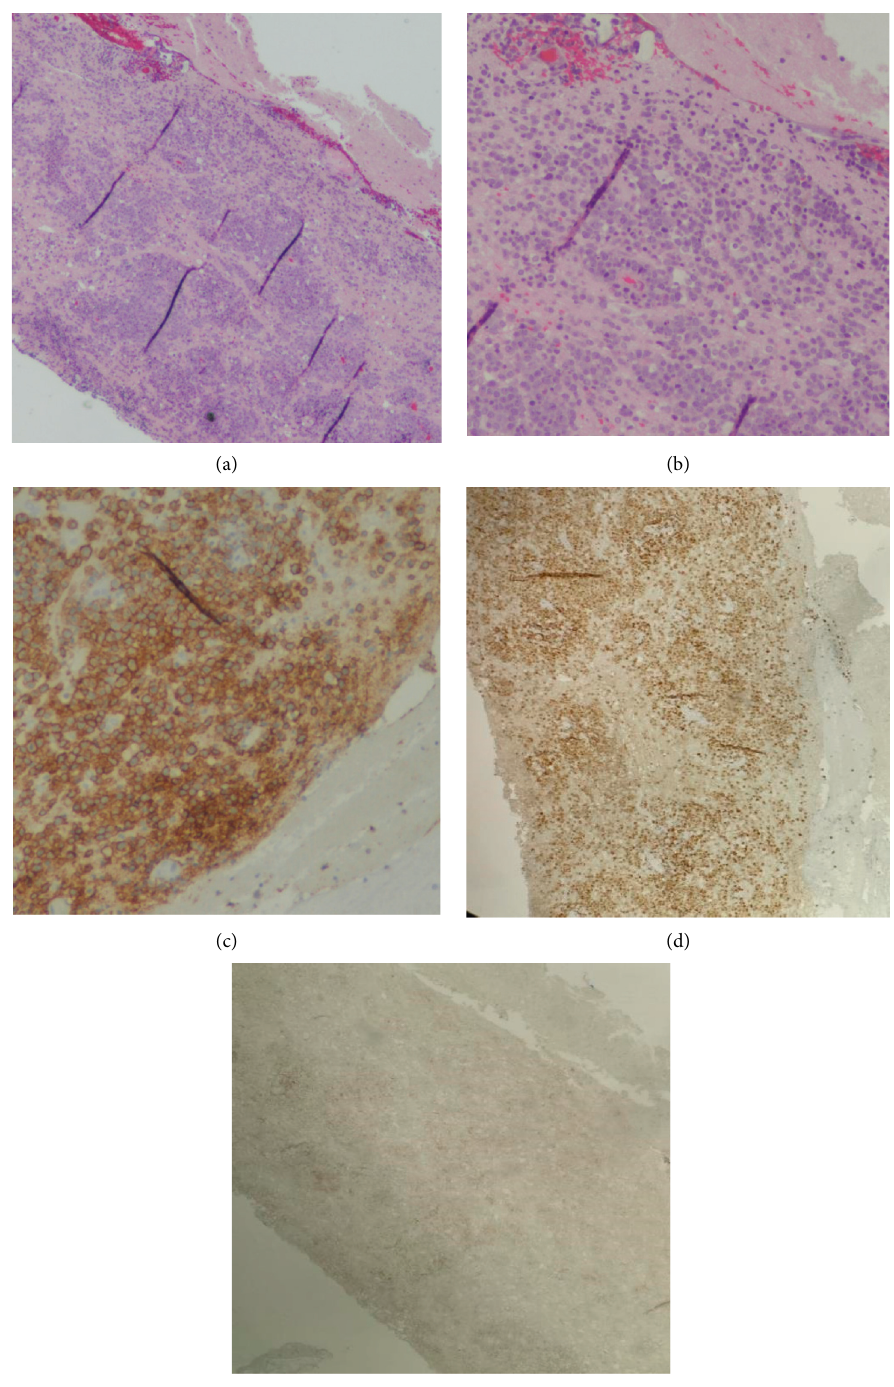
Figure 3: Parietal core brain biopsy of initial PCNSL mass. H and E stain showing neural tissue with infiltration of large round blue cells at 40x (a) and 100x (b). Positive CD20 stain highlighting the infiltration of large round blue cells at 100x (c). Positive MUM1 (d) and negative CD10 stains (e) supporting non-GCB